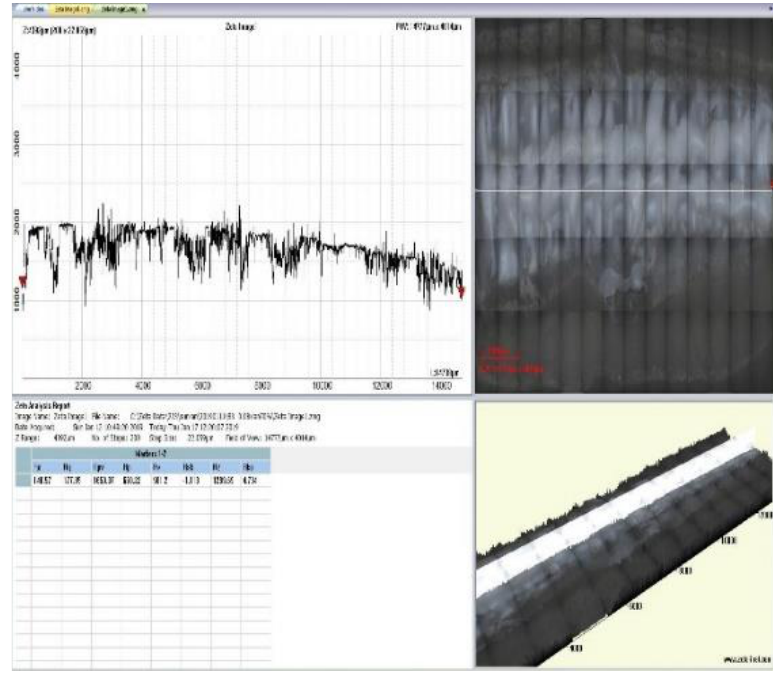
Figure 9. Zeta-20 test display interface.